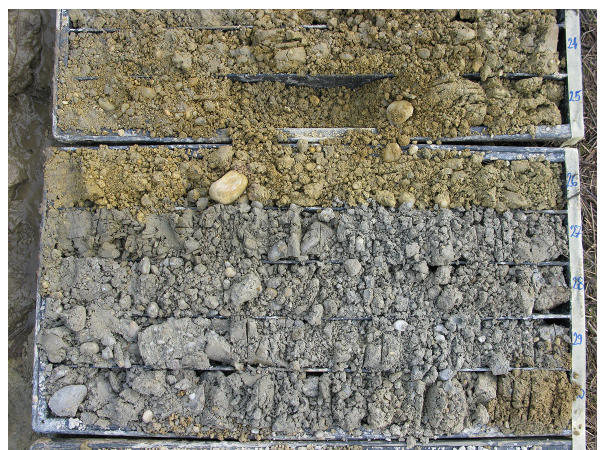
Figure 9. Gravel core from 23 to 30m depth from borehole SPB-3 – test field GW (Ður¯devac) (see Fig. 10a).